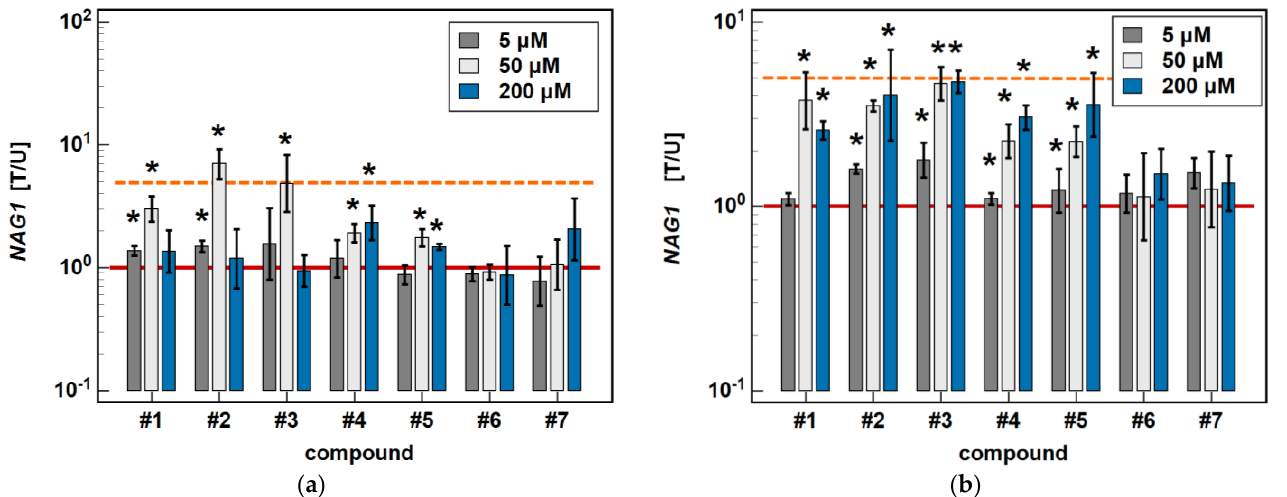
Figure 10. Dose-dependent effect of oxicams on NAG1 expression in ( a ) Caco-2 cells and ( b ) HCT 116 cells. The bars and whiskers represent the mean ± SD expression ratio of the normalized relative quantities [NRQ] obtained for cells treated with 5, 50, and 200 µ M oxicams for 24 h, and the corresponding untreated controls [T/U]. The significant differences between the treated and untreated cells, analyzed using a t -test for paired samples, are indicated by asterisks (*). An expression ratio of 1 (no change) is indicated by a red solid reference line, while an expression ratio of 5 (5-fold upregulation) and an expression ratio of 0.2 (5-fold downregulation) are indicated by an orange dashed reference line. Compound # 6 denotes piroxicam, and # 7 denotes meloxicam.